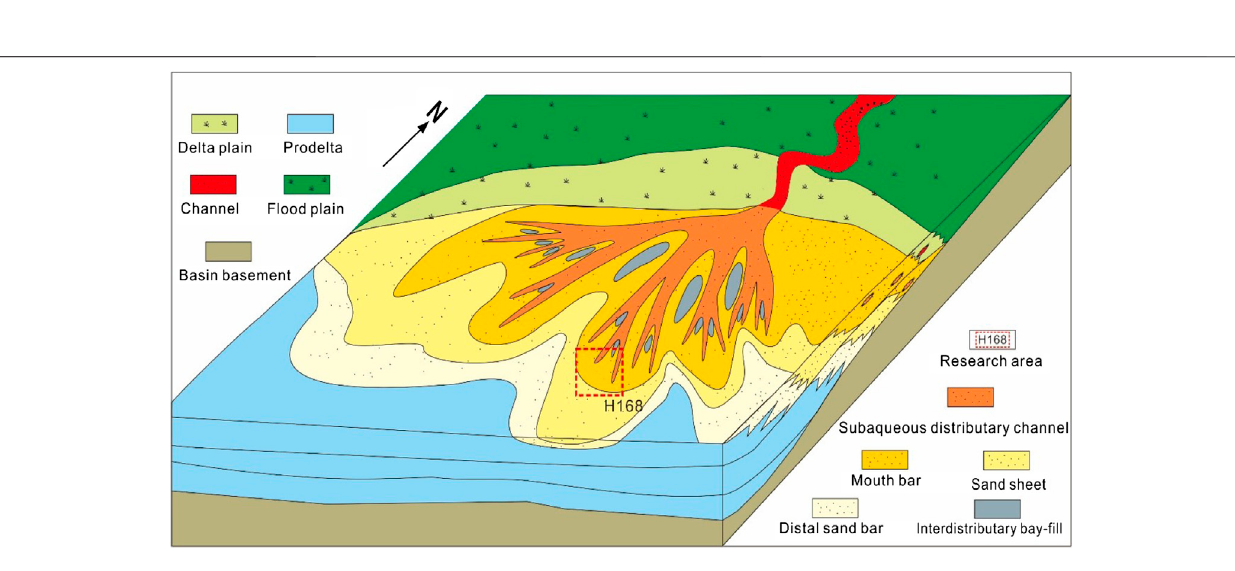
Frontiers in Earth Science |